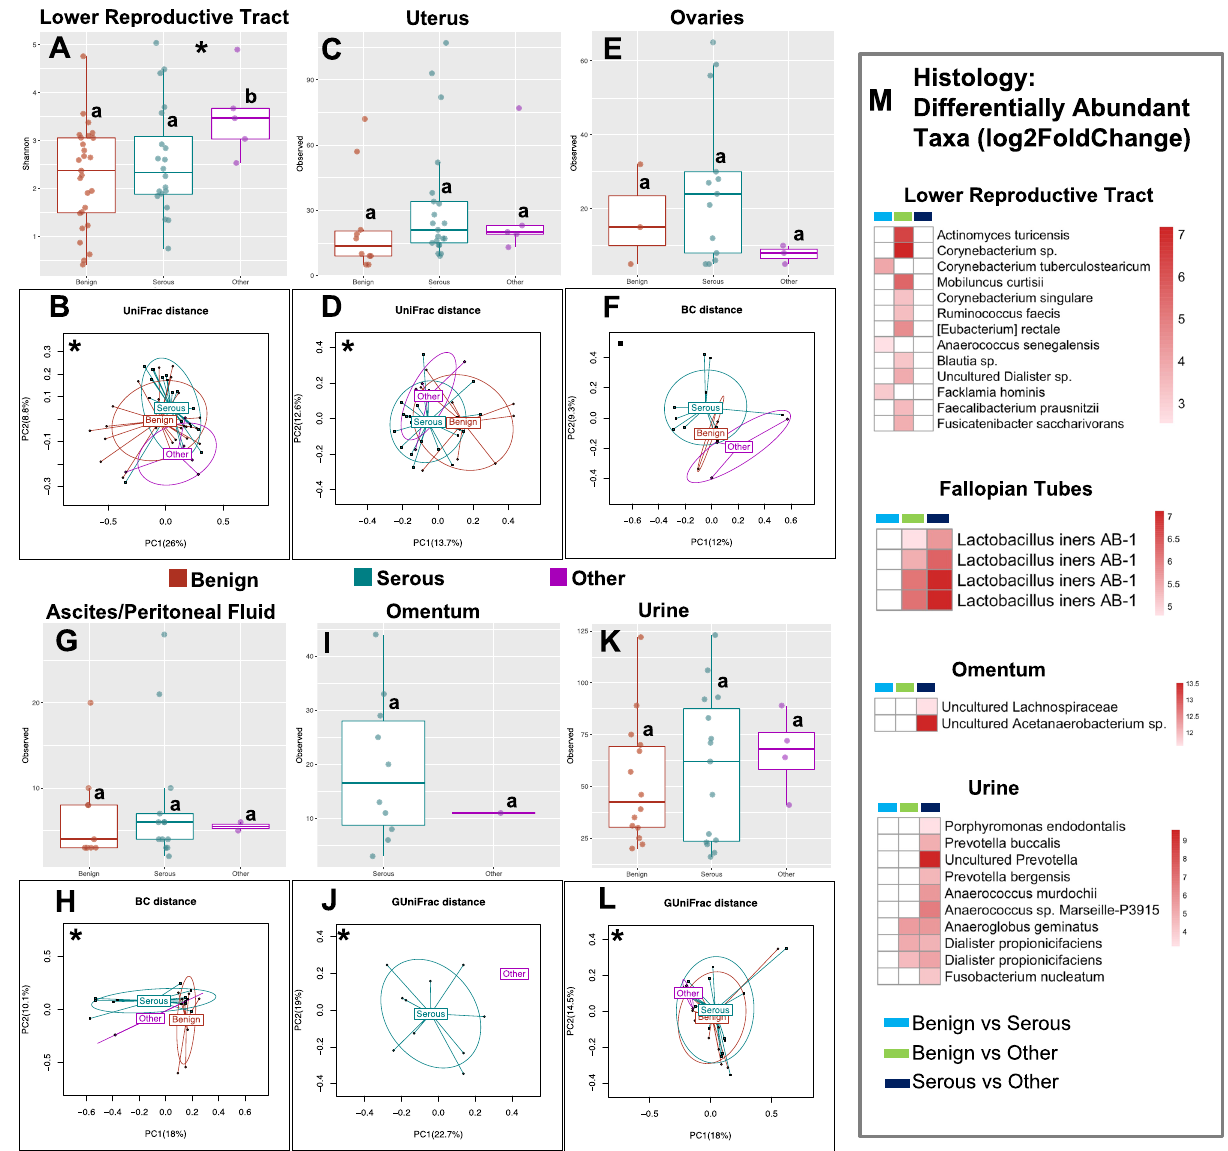
Figure 5. Bacterial community α- and β-diversities among patients with and without different histology of OC (OC). Both α- and β-diversities measures were compared. For α-diversity a Wald statistical test was performed and Observed ASVs was reported. For β-diversity, Bray–Curtis (BC), unweighted, and generalized UniFrac distance metrics were reported. The most significant metric is shown in each ordination plot. Lower reproductive tract (cervix and vagina), ( A ) α-diversity: Benign vs serous ( p = 0.021), others ( p = 0.859), ( B ) β-diversity: Benign vs serous ( p = 0.038), others ( p = 0.238), serous vs others ( p = 0.275). Uterus, ( C ) α-diversity: Benign vs serous ( p = 0.767), others ( p = 0.459), ( D ) β-diversity: Benign vs serous ( p = 0.002), others ( p = 0.123), serous vs others ( p = 0.400). Ovaries, ( E ) α-diversity: Benign vs serous ( p = 0.918), others ( p = 0.234), ( F ) β-diversity: Benign vs serous ( p = 0.051), others ( p = 0.433), serous vs others ( p = 0.138). Ascites/Peritoneal fluid, ( G ) α-diversity: Benign vs serous ( p = 0.636), others ( p = 0.807), ( H ) β-diversity: Benign vs serous ( p = 0.019), others ( p = 0.667), serous vs others ( p = 0.571). Omentum, ( I ) α-diversity: Serous vs others ( p = 0.377), ( J ) β-diversity: serous vs others ( p = 0.003). Urine, ( K ) α-diversity: Benign vs serous ( p = 0.360), others ( p =